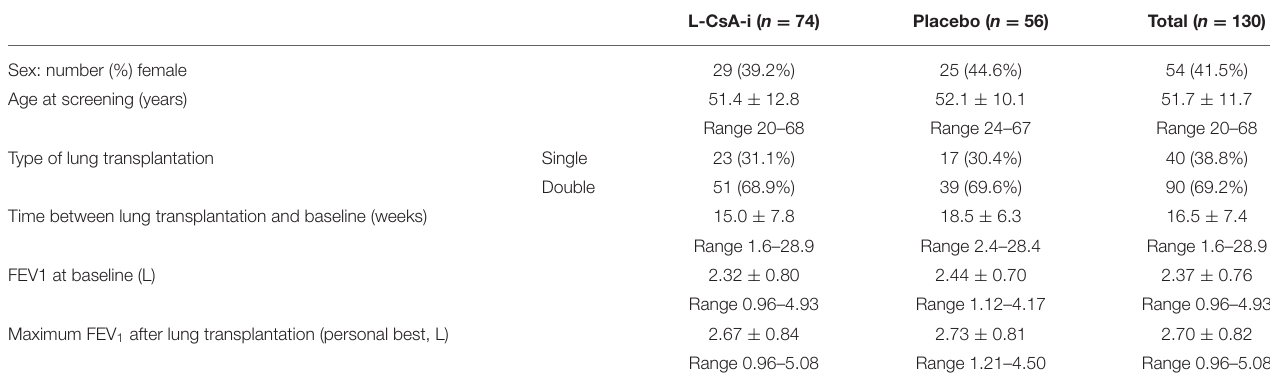
TABLE 1 | Baseline characteristics of study participants.